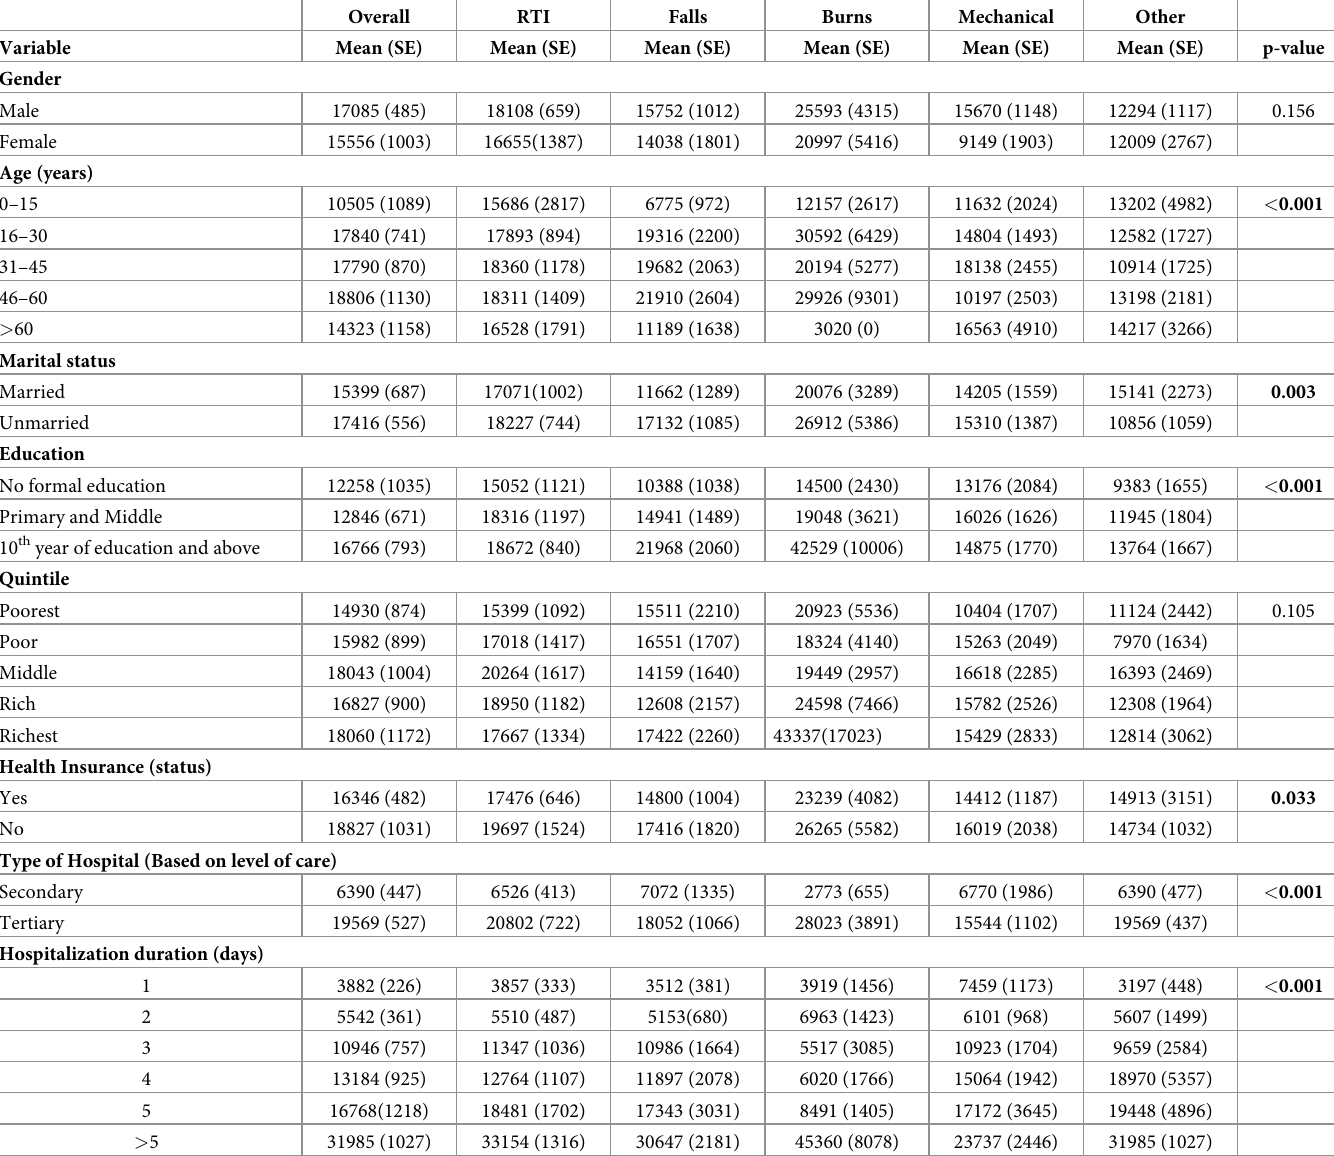
Table 3. OOP expenditure (INR) for injury-related hospitalization according to socio-economic characteristics of